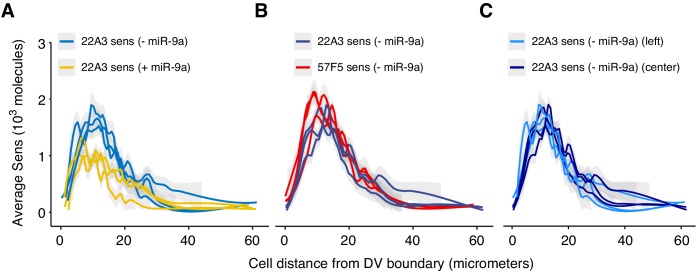
Average Sens expression as a function of cell position relative to the DV boundary.The DV boundary was manually drawn and Sens protein levels were measured as a function of the shortest distance from a cell to the boundary. Cells in both dorsal and ventral compartments were used in this analysis. Each line represents a moving line average from one wing disc. Shaded regions are 95% confidence intervals around the estimated average. (A) Effect of loss of miR-9a repression on sens located at 22A3. (B) Effect of transgene location at 22A3 or 57F5. (C) Effect of experimental replication on sens. Sets of discs were collected in separate experimental runs.